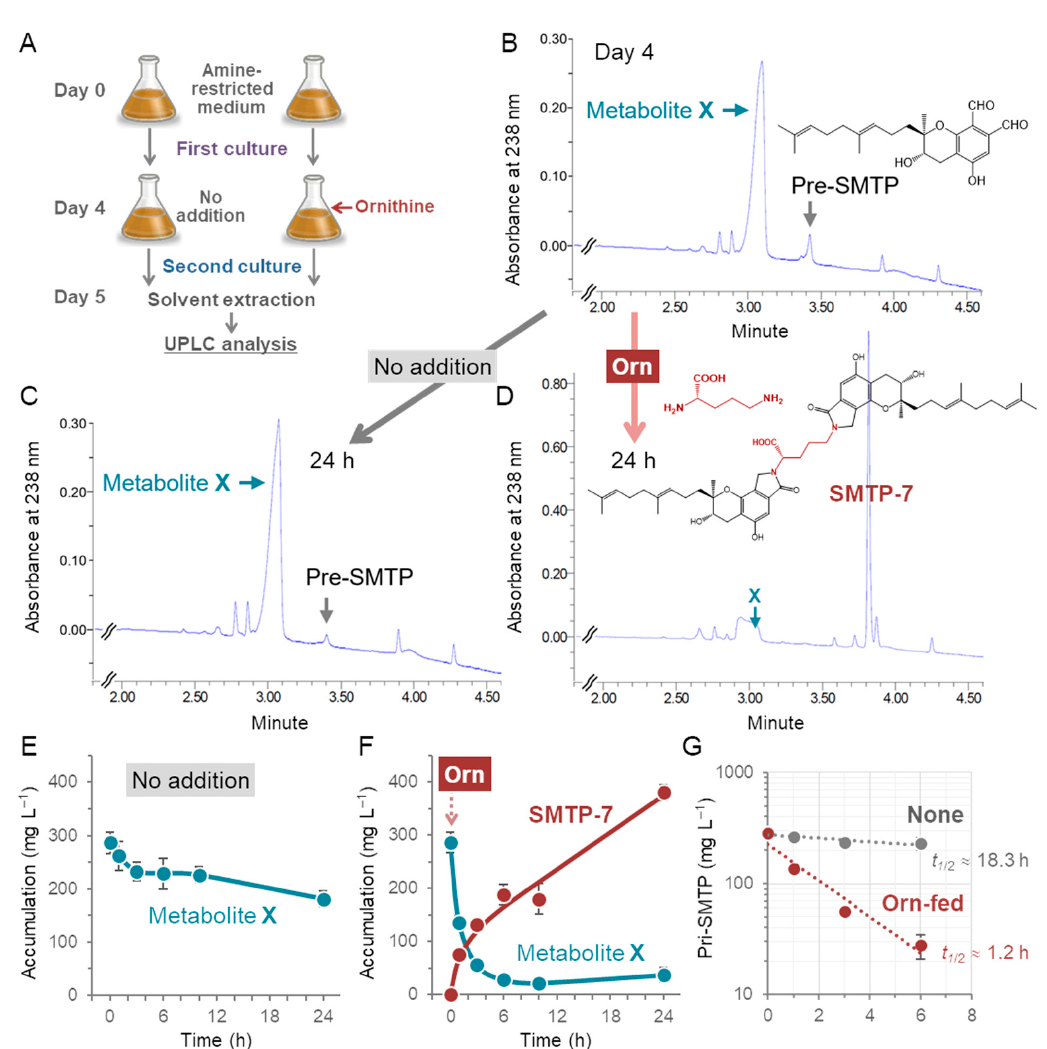
Figure 2. Identification of metabolites that accumulate in the amine-restricted culture and disappear following the amine feeding. ( A ) S. microspora was grown in the amine-restricted medium for 4 days and received L-ornithine or none on Day 4. After incubation for the indicated times, the cultures were extracted with MeCN, and the resulting extracts were analyzed using UPLC. ( B ) Before the amine feeding (Day 4), pre-SMTP and metabolite X accumulated in the culture. ( C ) These metabolites remained on Day 5 without the amine feeding on Day 4. ( D ) These metabolites were drastically consumed when L-ornithine was fed on Day 4. Instead, SMTP-7 accumulated after the L-ornithine feeding. ( E) Time course of the changes in the levels of metabolite X without amine feeding. ( F ) Time course of the changes in the levels of SMTP-7 after L-ornithine feeding. ( G ) The rate of the decay of priSMTP after feeding of L-ornithine or none. Metabolite X persisted without amine feeding, but it was rapidly cleared following the L-ornithine feeding, accompanying a concomitant accumulation of SMTP-7. The half disappearance time ( t 1/2 ) for metabolite X was estimated to be ~1.2 h